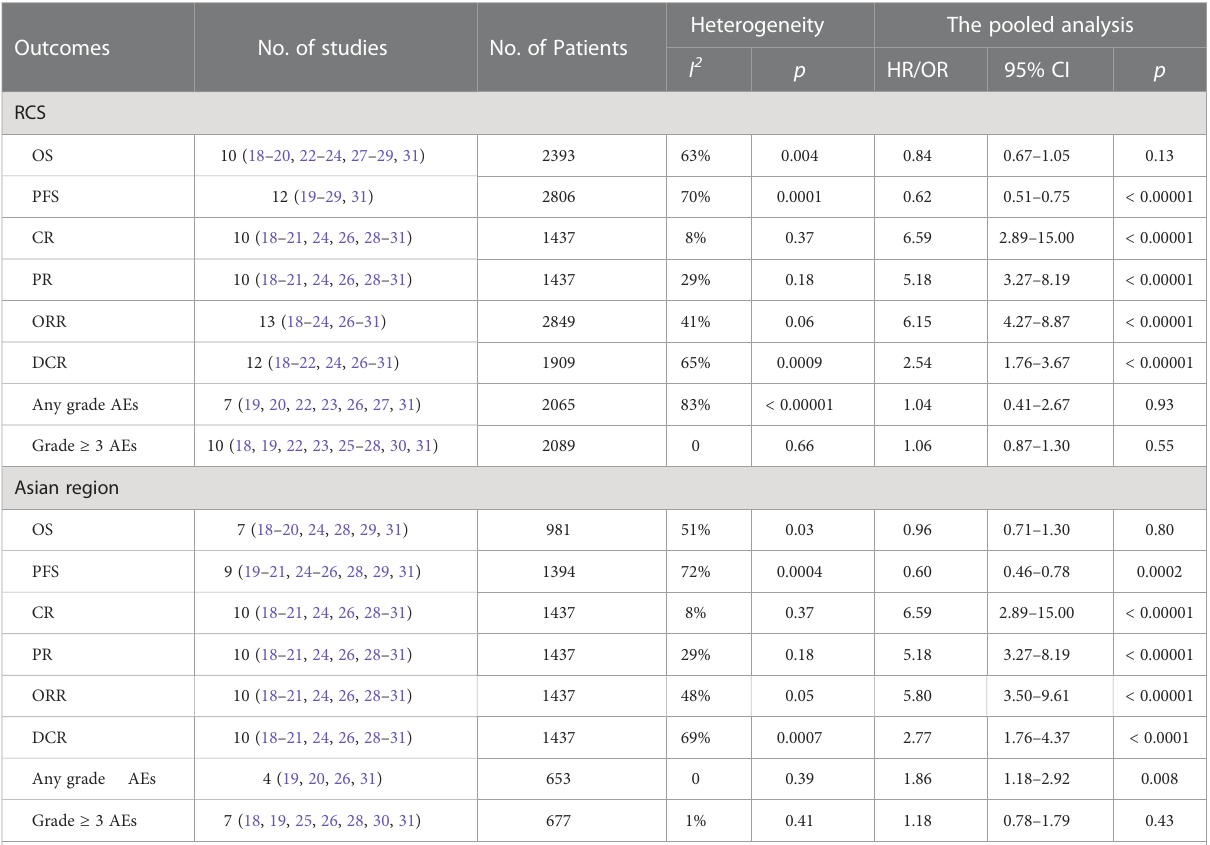
TABLE 3 Results of subgroup